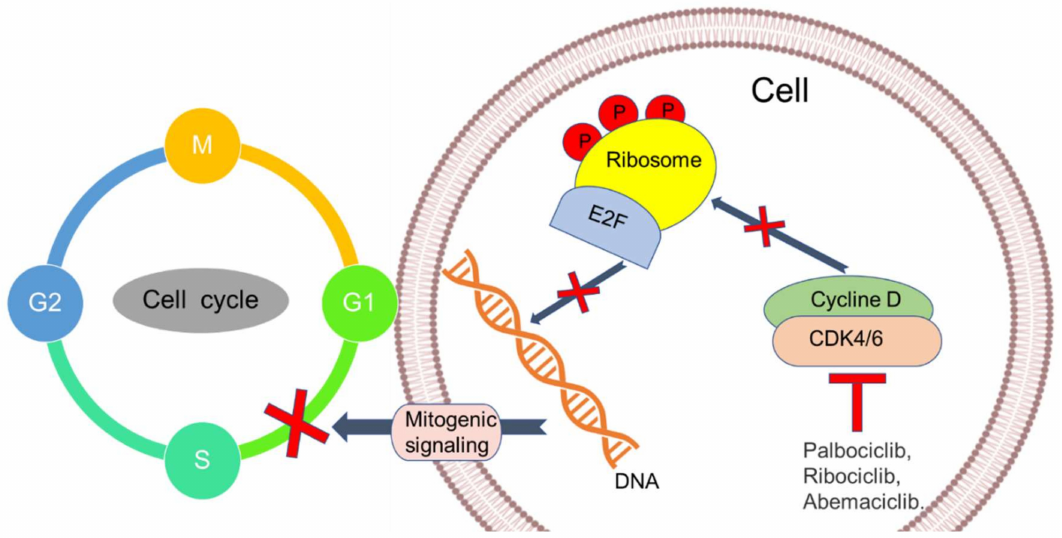
Figure 2. Schematic representation of the mechanism of CDK4 / 6 inhibitors. E2F—a group of genes that